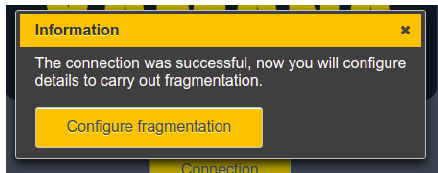
Figure 5. Setting up XAMANA’s remote connection to the user database. Figure 6. Remote connection status after using the data to test communication. Figure 6. Remote connection status after using the data to test communication.